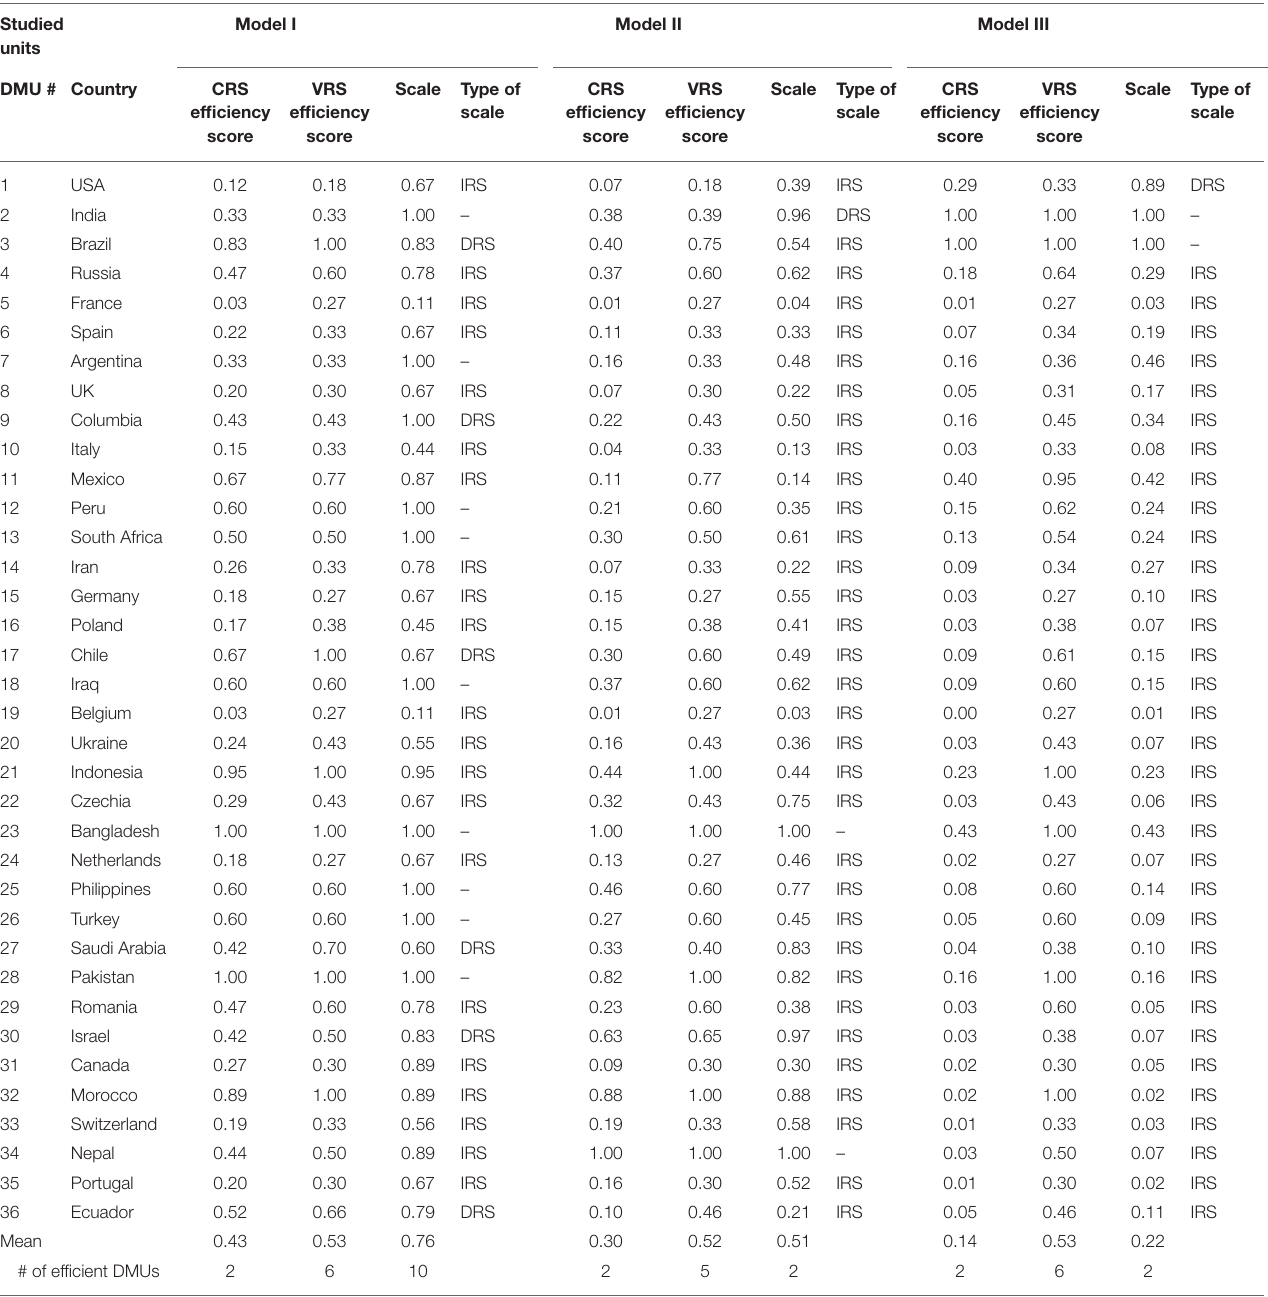
Based on data envelopment analysis efficiency calculated